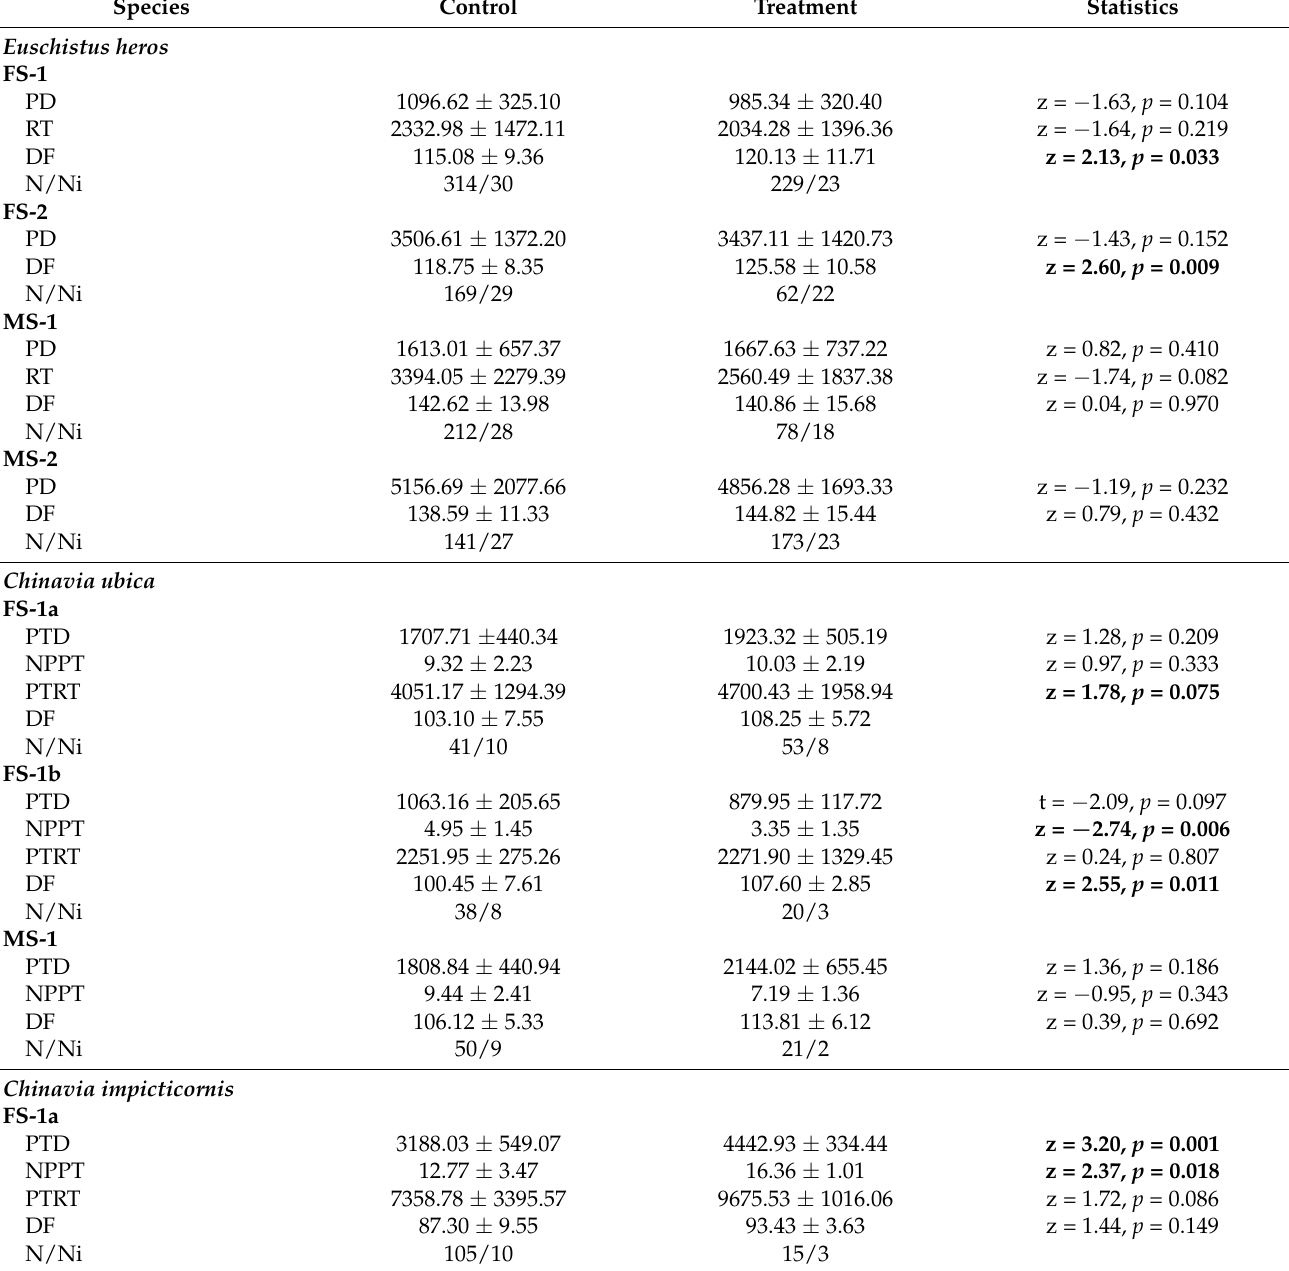
Table 1. Temporal and spectral characteristics of Euschitus heros , Chinavia ubica and C. impicticornis females and males when recorded from couples on bean plants without vibrations or vibrated with rival female signals from conspecifics in playback